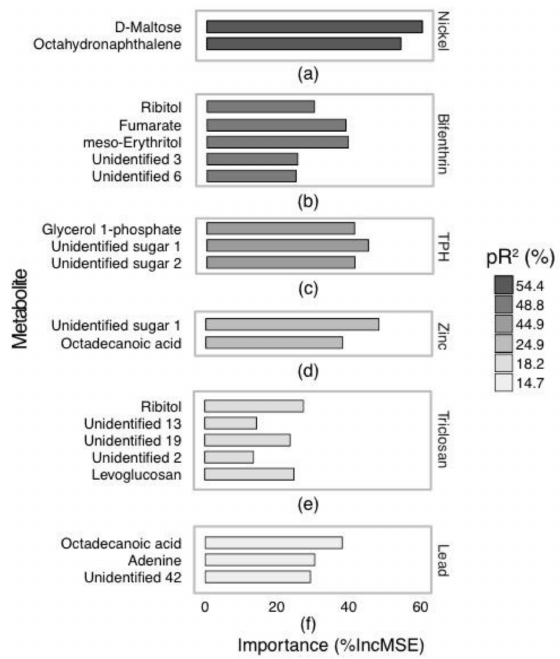
Figure 2. Relative importance of metabolites identified by GC-MS selected by model for association with ( a ) nickel, ( b ) bifenthrin, ( c ) total petroleum hydrocarbons (TPH), ( d ) zinc, ( e ) triclosan and ( f ) lead in Procladius villosimanus collected from 21 wetlands. Data were modelled with a random forest regression. Fills represent the goodness of fit of each model. Abbreviations: pR 2 , pseudo-R 2 ; %IncMSE, percent increase in mean squared